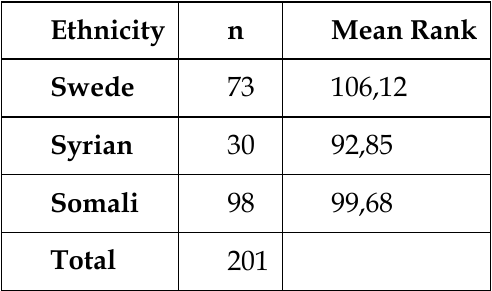
Figure 7. Trust towards the health centre and ethnicities. Percentage per reported value on scale 5-1. Swedes n=73, (100%); Syrians n=30, (100%), Somalis n=98 (100%). Total n=201. ‘Swedes’ in Skäggetorp express somewhat higher trust in the health centre than the ‘Syrians’. Just like expressed regarding the question about concern for privacy and surveillance. Table 16. Trust towards the health centre and ethnicity. Kruskal-Wallis mean rank.